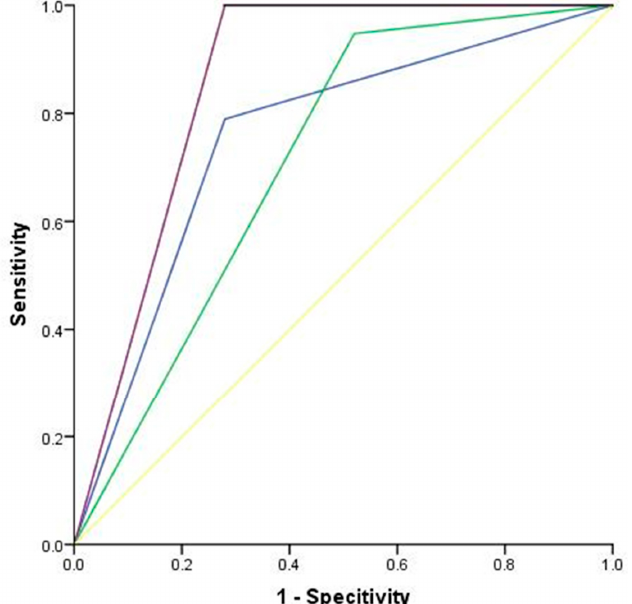
Figure 4. ROC curves for rFA and FA Laterality Index within 3 months post-stroke for prediction of Upper-Extremity motor outcome by UE-PG ≤ 1 after 1 year. The areas under the curve were lower for rFA (blue line) and FA laterality index (green line) obtained in MCP than that in CP (0.755 vs. 0.86, 0.714 vs. 0.86, respectively). The purple line represents rFA obtained in CP. The straight light-yellow line represents 50% of the area under the curve.